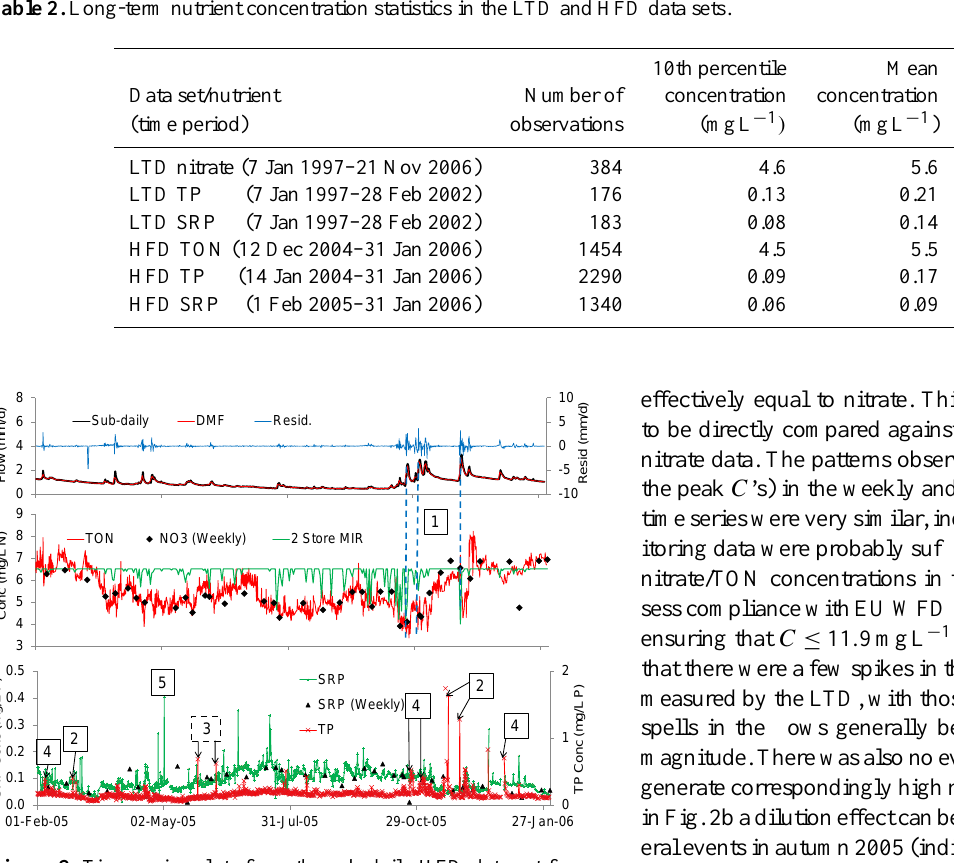
Table 2. Long-term nutrient concentration statistics in the LTD and HFD data sets.